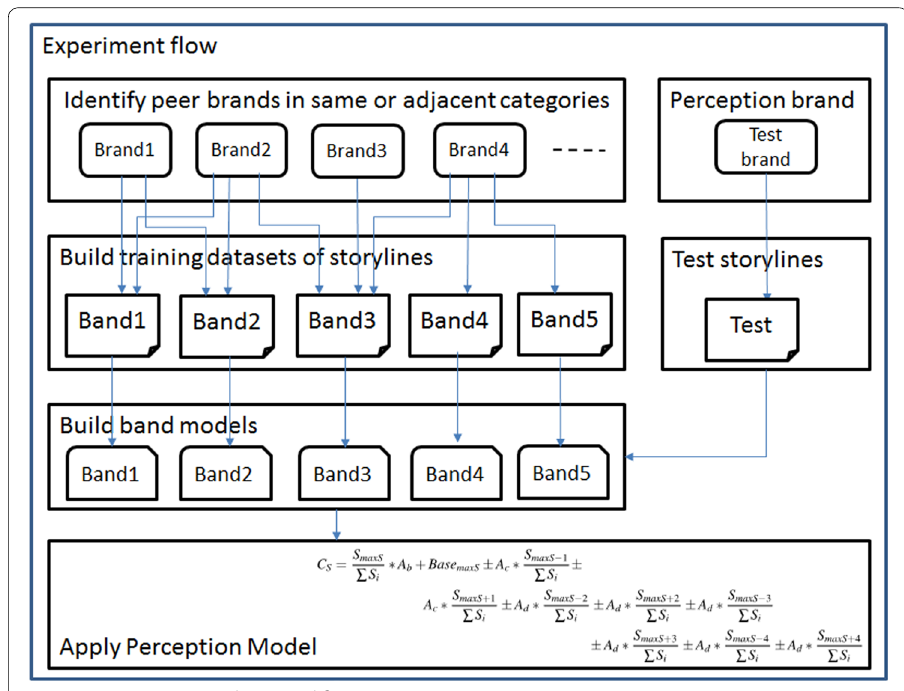
Fig. 4 DERIV experiment design and